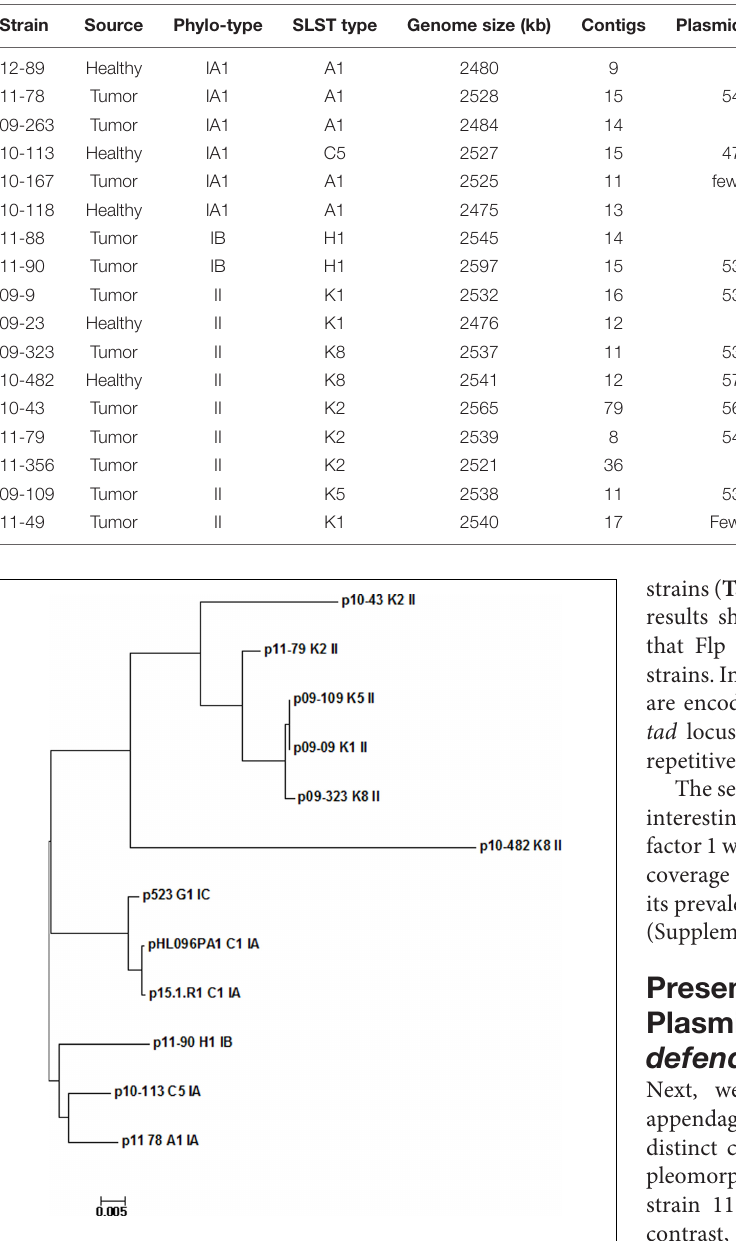
FIGURE 1 | Phylogenetic analysis of large plasmids from C. acnes types I and II strains. Plasmids of type I strains [SLST types A1, C1, C5 (all type IA), G1 (type IC), H1 (type IB)] cluster together in two clades and are distinct from a clade of plasmids from type II strains (SLST types K1, K2, K5, K8). Sequences were aligned with MAFFT and the phylogenetic tree was built in